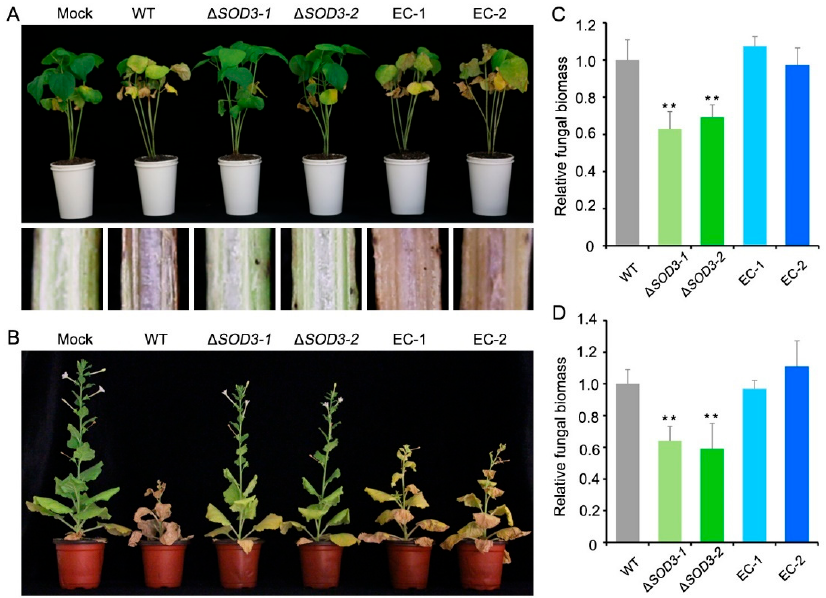
Figure 6. VdSOD3 contributes to virulence of V. dahliae on host plants. ( A ) The disease symptoms of cotton seedlings inoculated with the indicated strains (Top) and the discoloration of the inoculation shoot longitudinal sections (bottom). ( B ) Phenotypes of N. benthamiana plants inoculated with the indicated strains. The fungal biomasses of each fungal strain in cotton ( C ) and N. benthamiana ( D ) were determined by RT-qPCR. Error bars represent standard deviations ( n = 3). Asterisks ** indicates significant differences ( p < 0.01) by Student’s t -test.